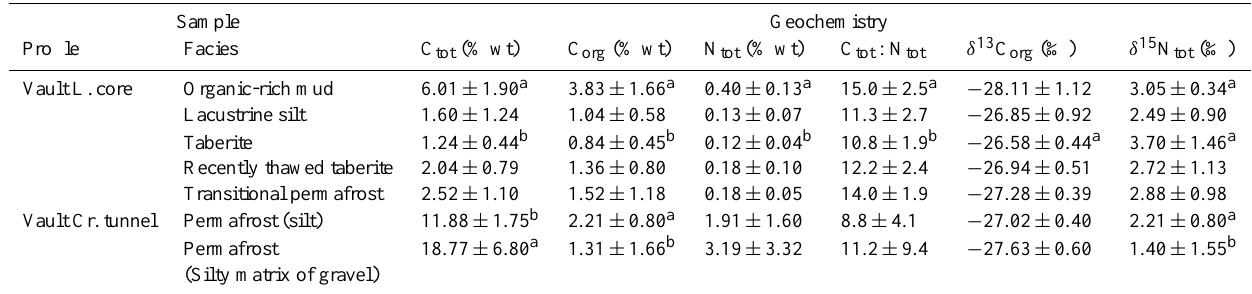
Table 4. Summary of geochemical properties and stable isotopes measured on sediment samples from the Vault Lake core and Vault Creek permafrost tunnel. Data are presented as mean ± SD.